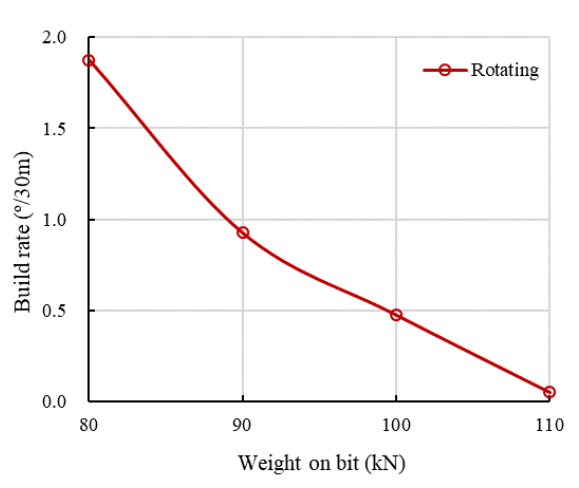
Fig. 15. Rotating build rate VS inclination for BH-PDM-D BHA